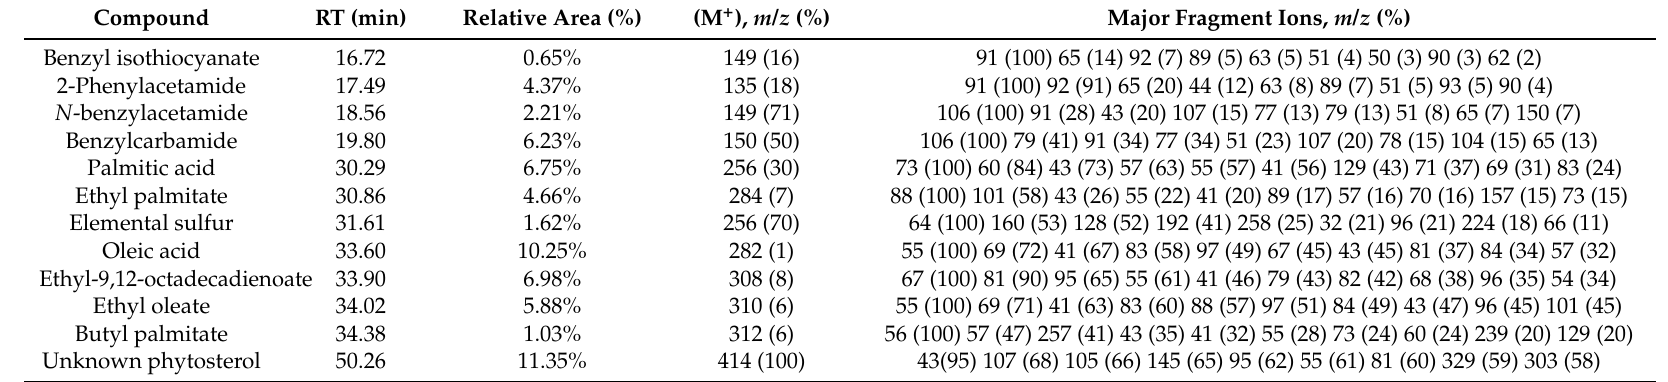
Table 4. Identified compounds from chloroform fraction (CfF) of the CE from T. pentaphyllum tubers by